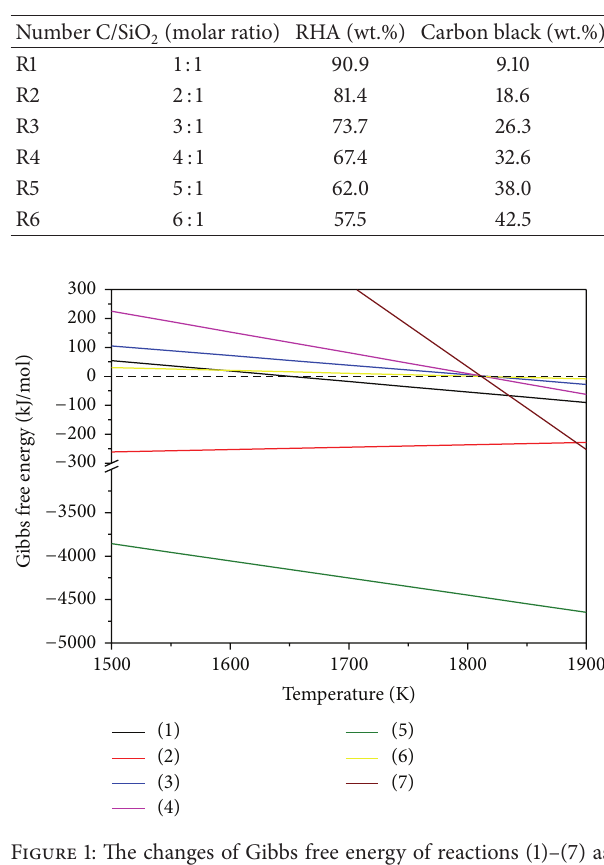
Table 2: Compositions of mixture powders.